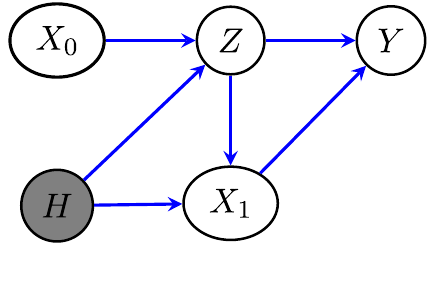
Figure 11: Observational